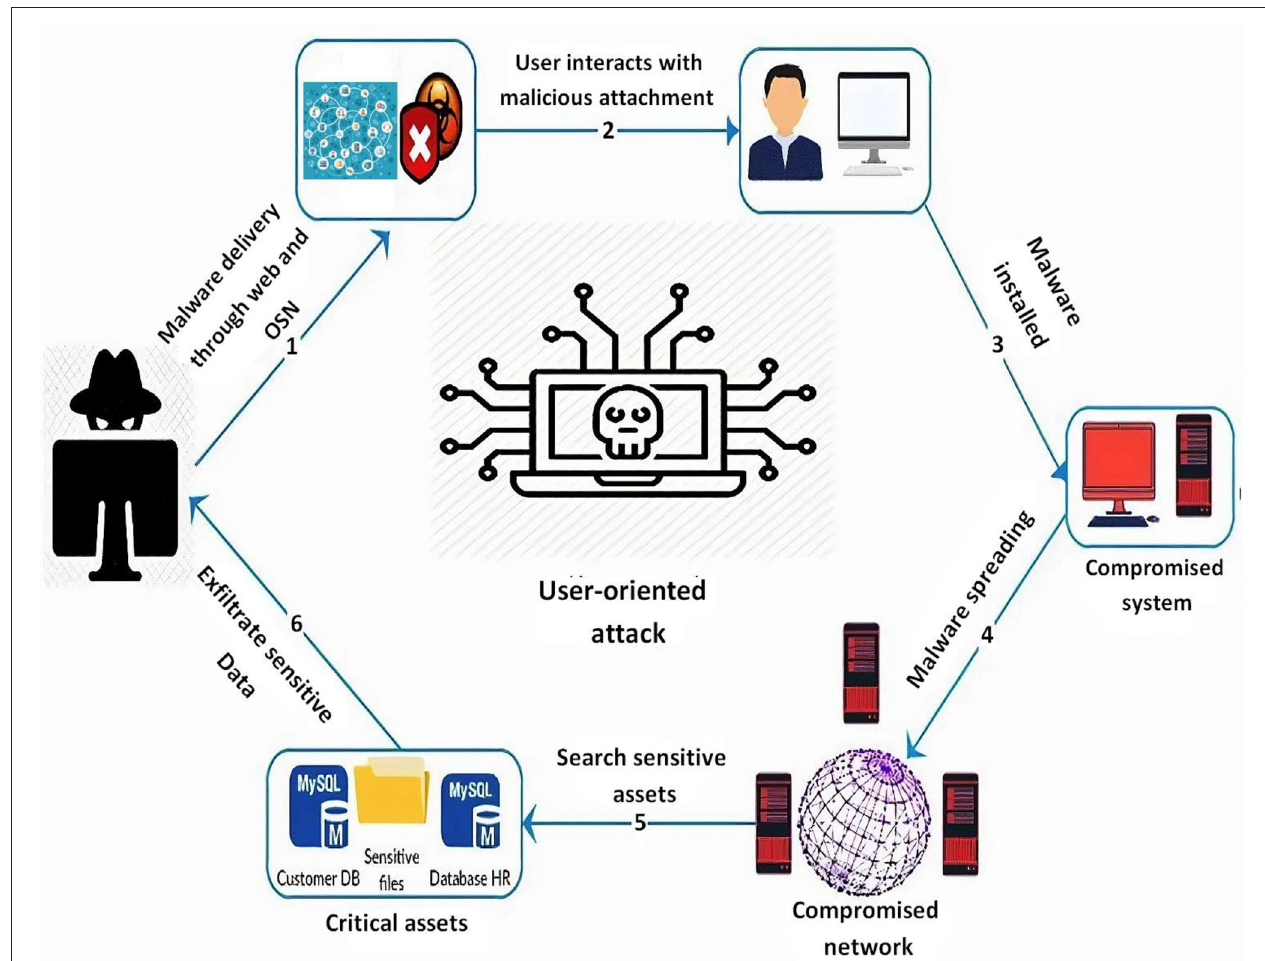
FIGURE 1 | The autopsy of a user-oriented